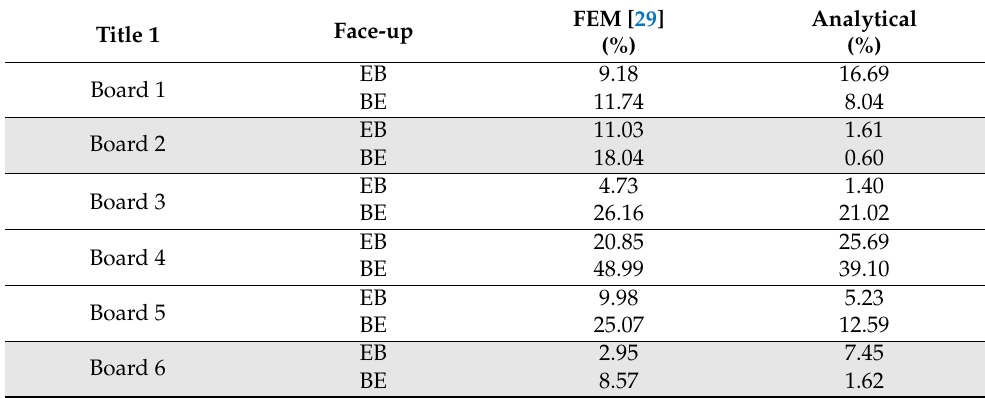
Table 6. Percentage error between BS measured experimentally and computed